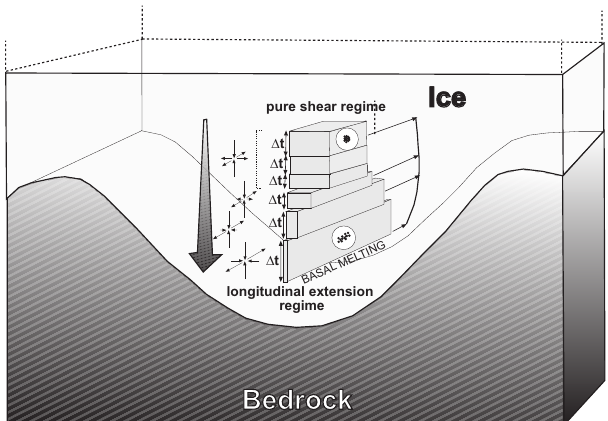
Figure 7. Schematic illustration of the hypothesized impact of the confining bedrock topography (bedrock valleys about 20km wide and 200–400m deep – from Remy and Tabacco, 2000) on the stress regime, layer thickness and ice fabric patterns in the bottom ice of EPICA Dome C. Vertical stretching is accommodated by basal melting and/or along sub-glacial valley flow. For clarity, this illus- tration enhances the process so that absolute annual layer thickness increases downwards. A milder effect would only result in a de- crease of the thinning rate (see text for